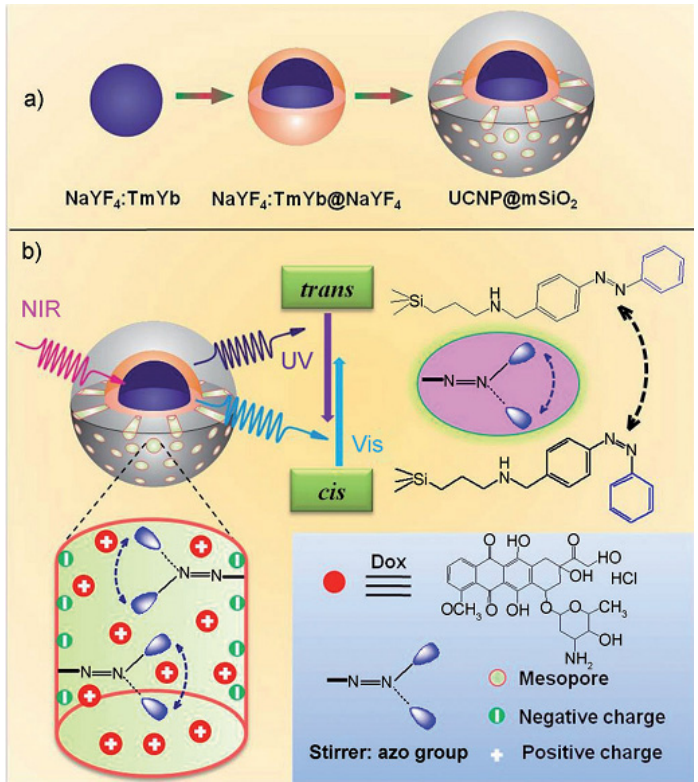
Figure 4. ( a ) Synthetic procedure for up-converting nanoparticles coated with a MSN outer layer. ( b ) The schematic of NIR light-triggered doxorubicin release by making use of the up-conversion property of UCNPs and trans-cis photoisomerization of azobenzene group molecules grafted on MSNs. Reproduced with permission from [62]. Copyright John Wiley and Sons,